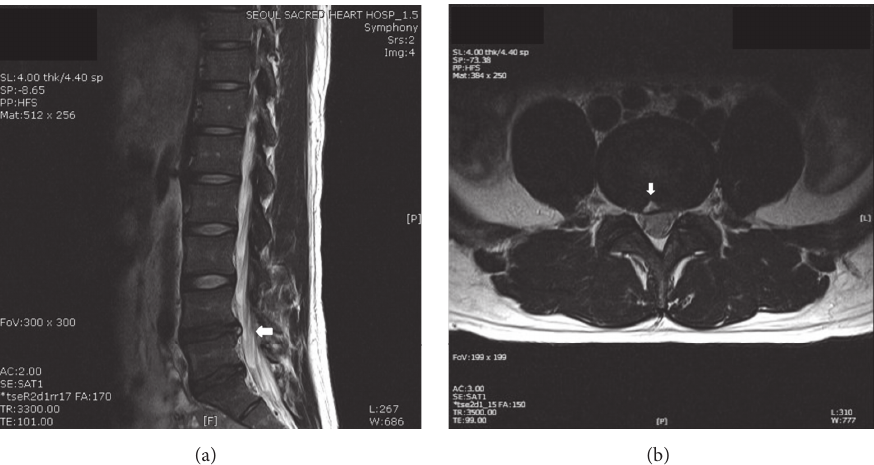
Figure 2: A T2-weighted magnetic resonance image showing the high-intensity zone (arrow) in a patient with a L4-5 herniated lumbar intervertebral disc. Sagittal view (a) and axial view